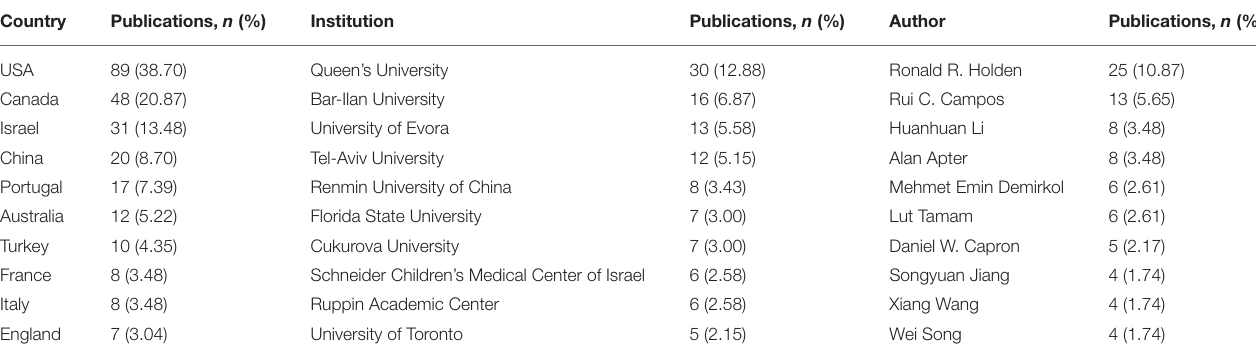
TABLE 1 | The top 10 countries, institutions and authors in terms of publications included in WoS database during 1994–2020.